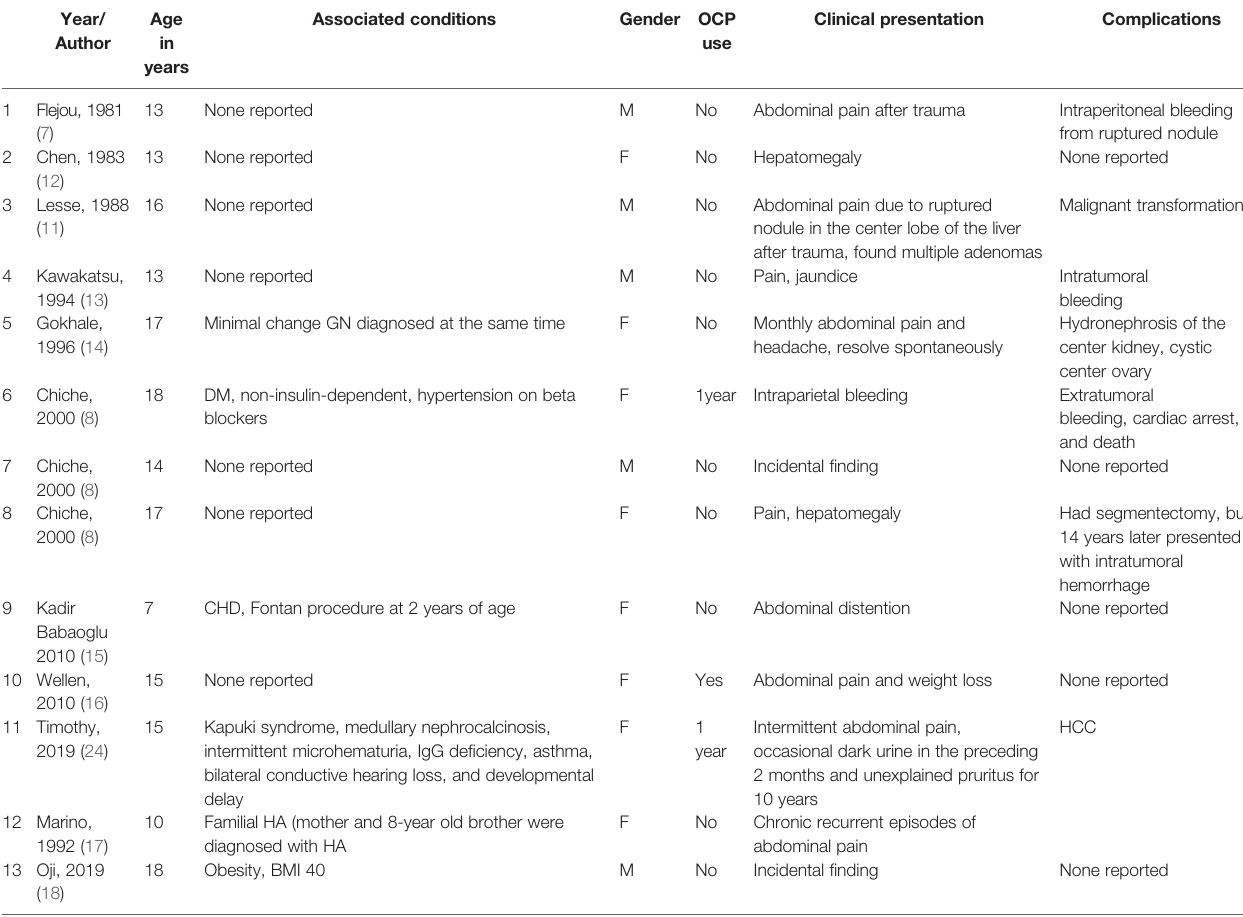
TABLE 2 | All pediatrics cases of LA reported in literature from years 1981 to